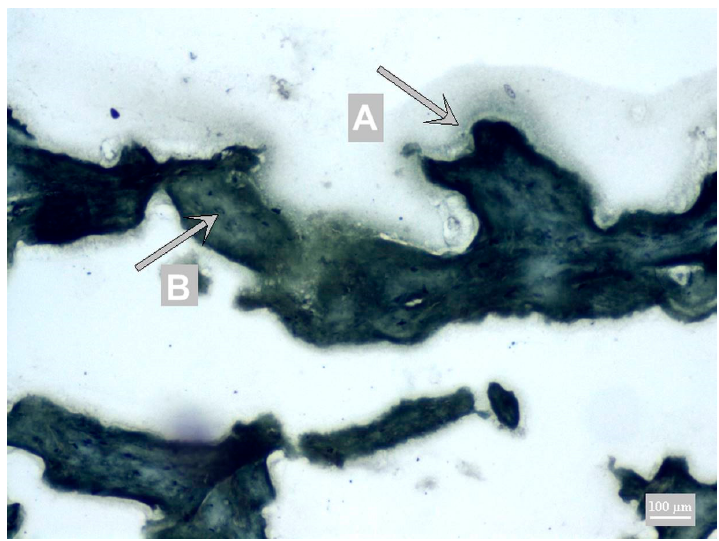
Figure 2. Toluidine Blue with DAB chromogen; A chromogen precipitate—calcium caseinate (blue-brown); B muscle fiber (blue). The Toluidine Blue stains other structures blue, blue-violet to blue-gray. Because